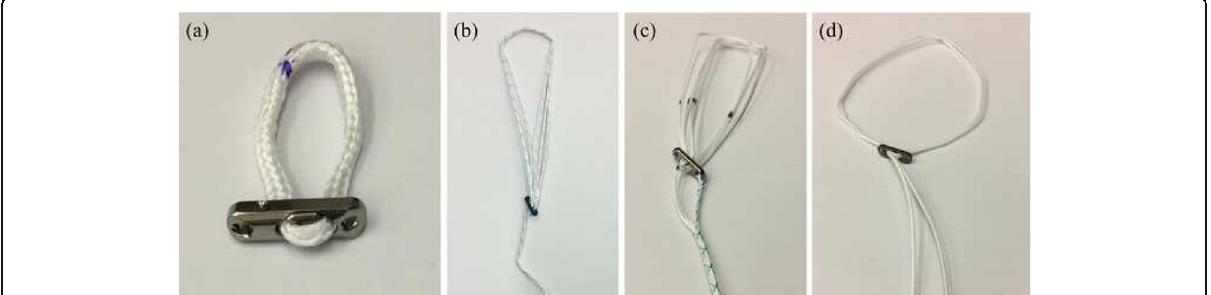
Fig. 1 Fixed and adjustable femoral cortical suspension devices tested in the current study: a G-Lok (Stryker Sports Medicine, Greenwood Village, Colorado, USA), b UltraButton (Smith & Nephew, Andover, Massachusetts, USA), c RigidLoop Adjustable (DePuy Mitek, Raynham, Massachusetts, USA), and ( d ) ProCinch RT (Stryker Sports Medicine, Greenwood Village, Colorado,